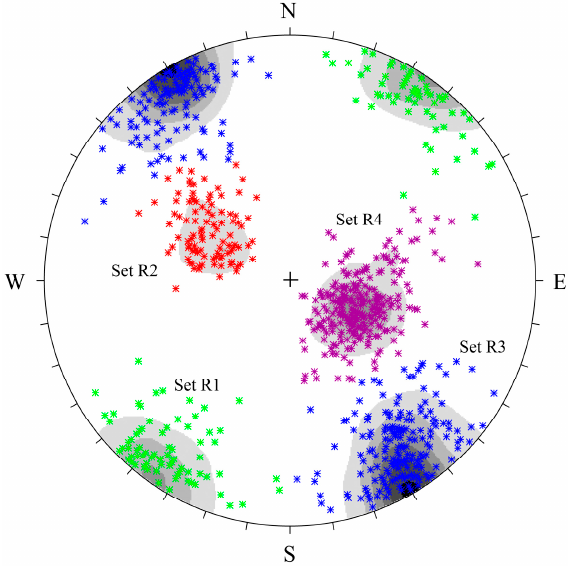
Figure 4. Equal-area projection diagram for fracture sets located in the dam site area.